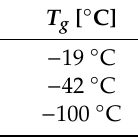
Table 4. Rubber compounds used for the interlayer in the armored laminates tested.